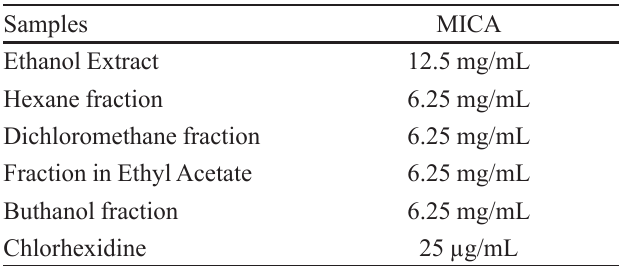
TABLE VI - Results of extent of inhibition halos (mm), obtained in studiesof mouthwash with ethanol extract of Rosmarinus officinalis , in concentrations of 0.1, 5 and 10% tested against S.